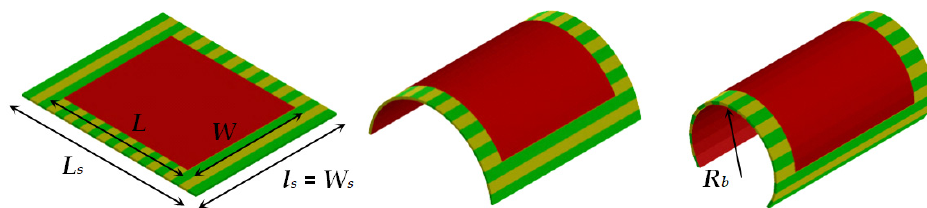
Figure 10. 3D view of flat and bent microstrip resonators of length L = 30 and width W = 26 mm on sliced substrates with length L s = 42 and width W s = 34 mm (last two cases with bending radius R b = 14.3 and 9.6 mm).